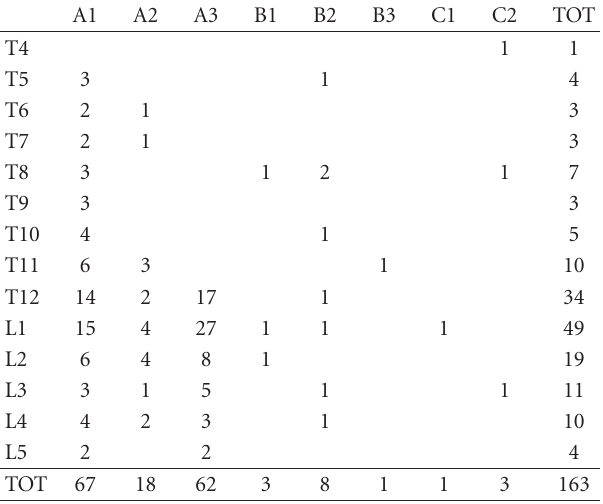
Table 1: Fractures distribution according to the type and